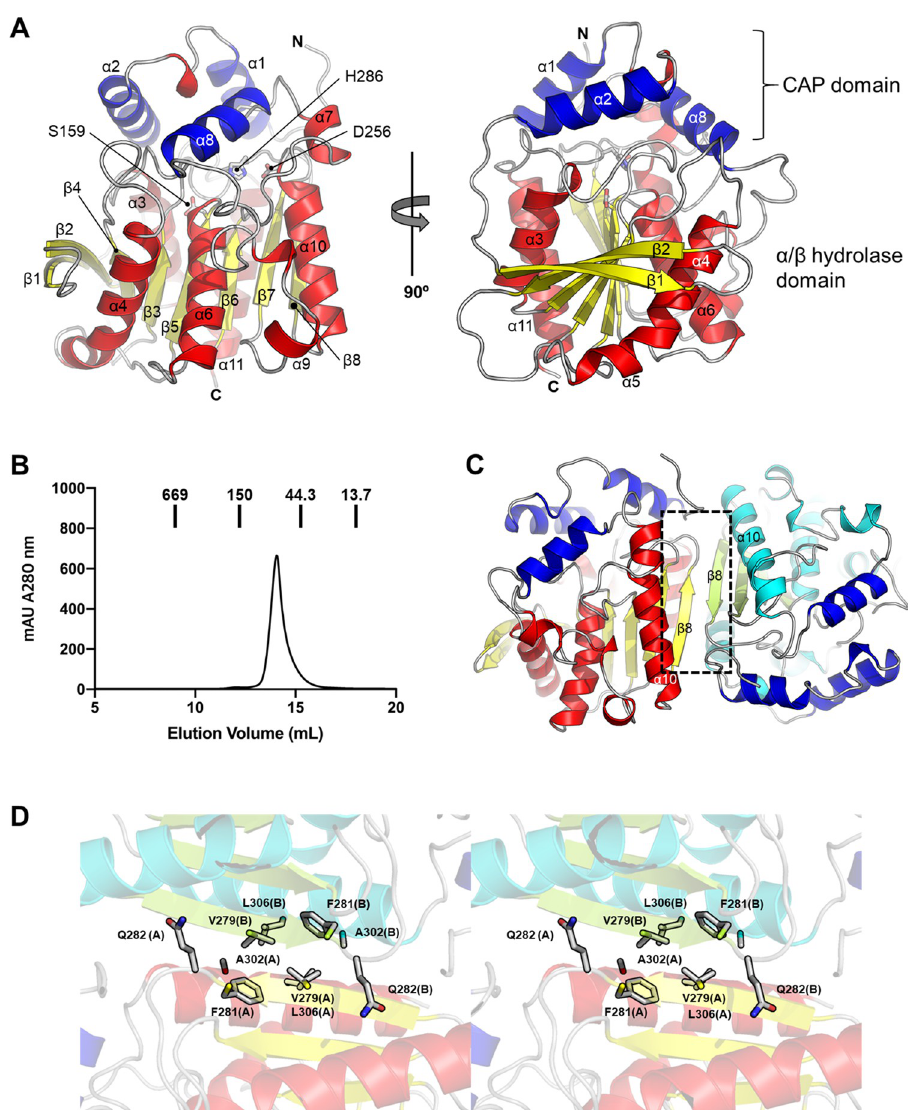
Fig 2. Overall structure of Lg EstI and dimer state. (A) Cartoon representation of the Lg EstI monomer with a front view (left) and 90˚ rotated view (right). The CAP domain made up of three triangular helices; α 1, α 2, and α 8 are shown with blue, while the α / β hydrolase domain is indicated with red for helices and yellow for strains. The residues of the catalytic triad (Ser159, Asp256, and His286) are represented by a stick. (B) Size exclusion chromatography (SEC) profile of Lg EstI. Measured molecular mass of Lg EstI was 70.91 kDa, which is close to the sequence-based molecular weight of the dimer (72.05 kDa). (C) Overall dimer presentation of Lg EstI and the dimer interface is indicated with a dotted square. (D) Stereo view of the dimer interface of Lg EstI. Residues involved in the dimeric interface of Lg EstI are represented with sticks. The chains are differentiated with color: red for chain A and cyan for chain B, and marked after the residue number with